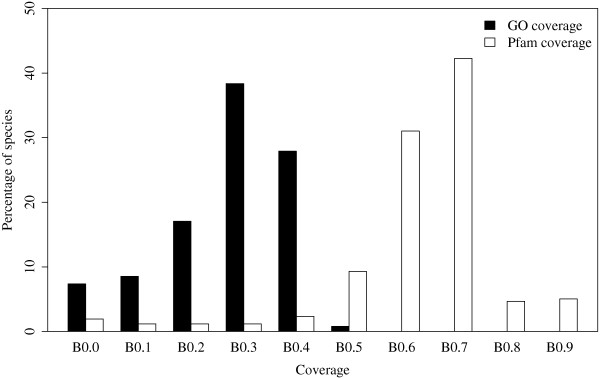
Distribution of the GO coverage and Pfam coverage. Distribution of the GO coverage and Pfam coverage from UniProt proteins of completely sequenced genomes. GO coverage means proteins annotated with molecular function and biological process and disregarding cellular component. The mean GO coverage for species in the database is 32%. The Pfam annotation is more complete with a mean of 67%. The bins correspond to the following intervals of coverage: B0.0: [0.0, 0.1[; B0.1: [0.1, 0.2[; B0.2: [0.2, 0.3[; B0.3: [0.3, 0.4[; B0.4: [0.4, 0.5[; B0.5: [0.5, 0.6[; B0.6: [0.6, 0.7[; B0.7: [0.7, 0.8[; B0.8: [0.8, 0.9[; B0.9: [0.9, 1.0].